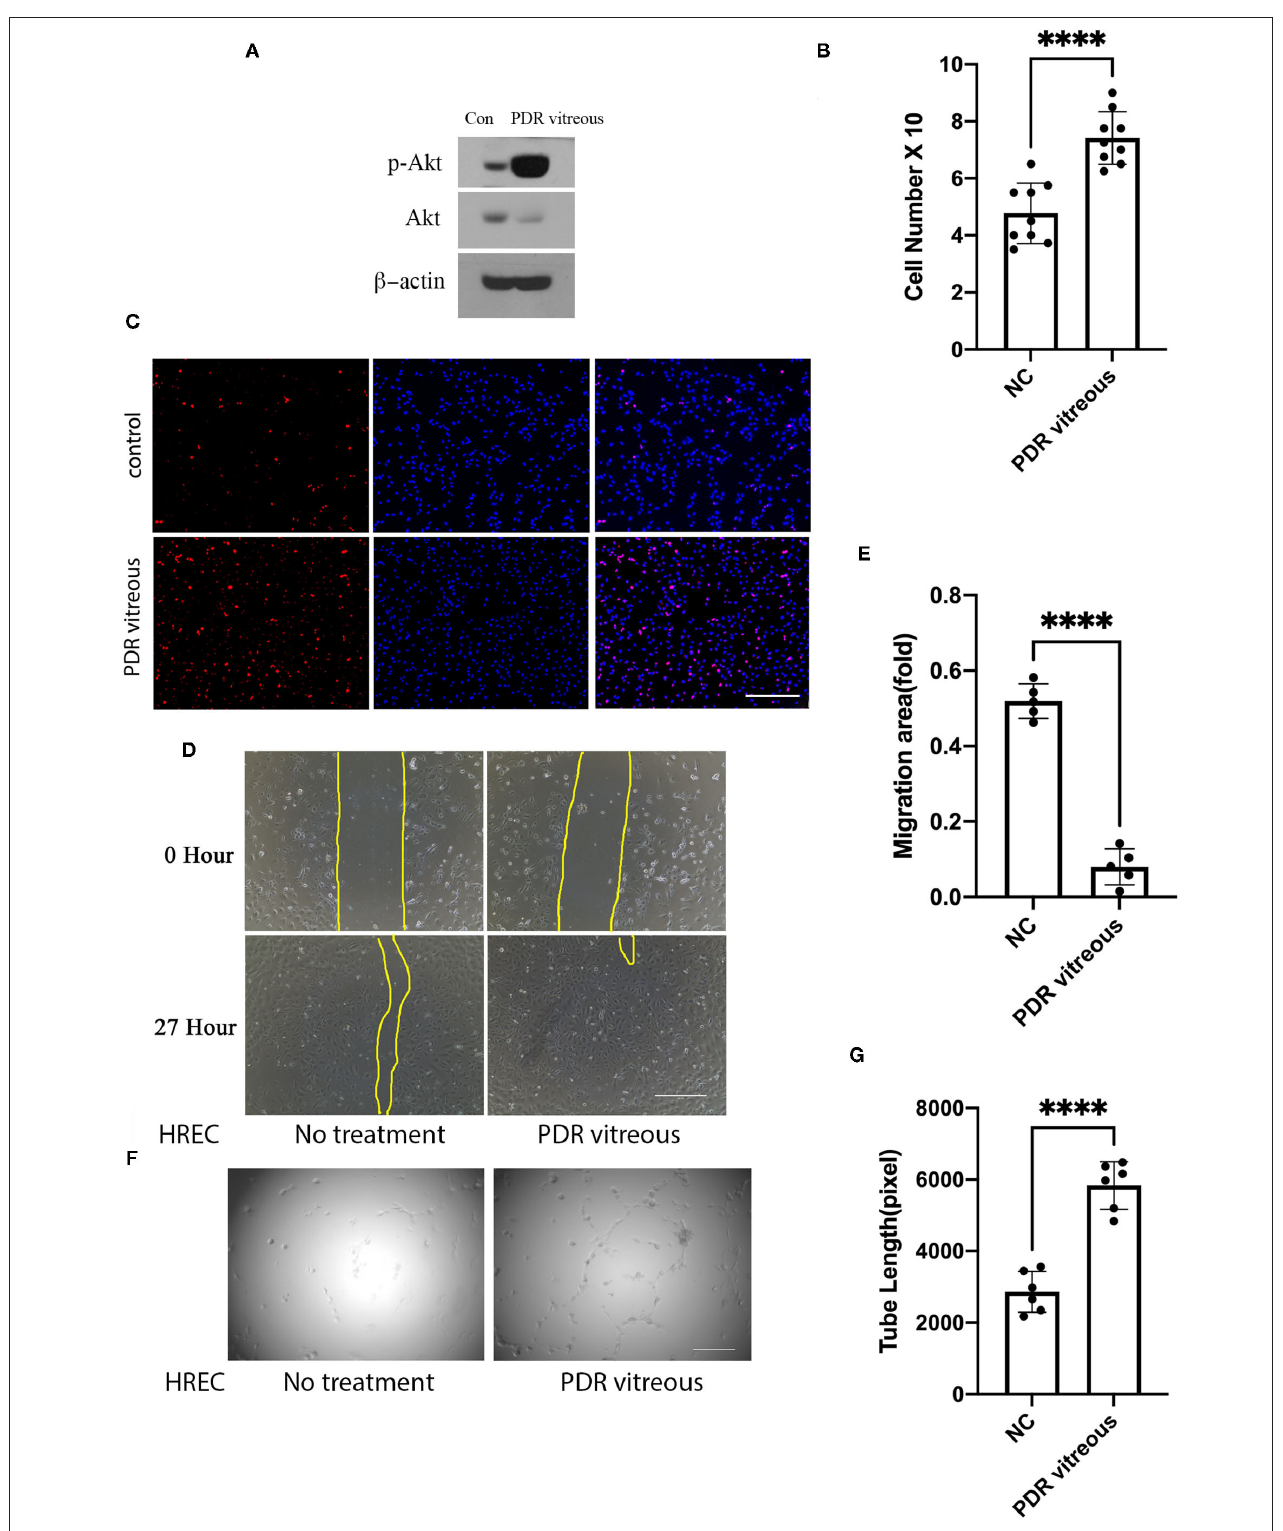
FIGURE 2 | PDR vitreous enhanced proliferation, migration, and tube formation of vascular endothelial cells. (A) Western blot analysis of p-Akt in HRECs induced by PDR vitreous. This is representative of three independent experiments. (B,C) Proliferation of HRECs induced by PDR vitreous was assessed using two methods. (B) Total cell number counting; (C) Ki67 staining of proliferative cells. Scale bar: 1,000 µ m. (D,E) A wound healing assay to measure the migration of HRECs stimulated by